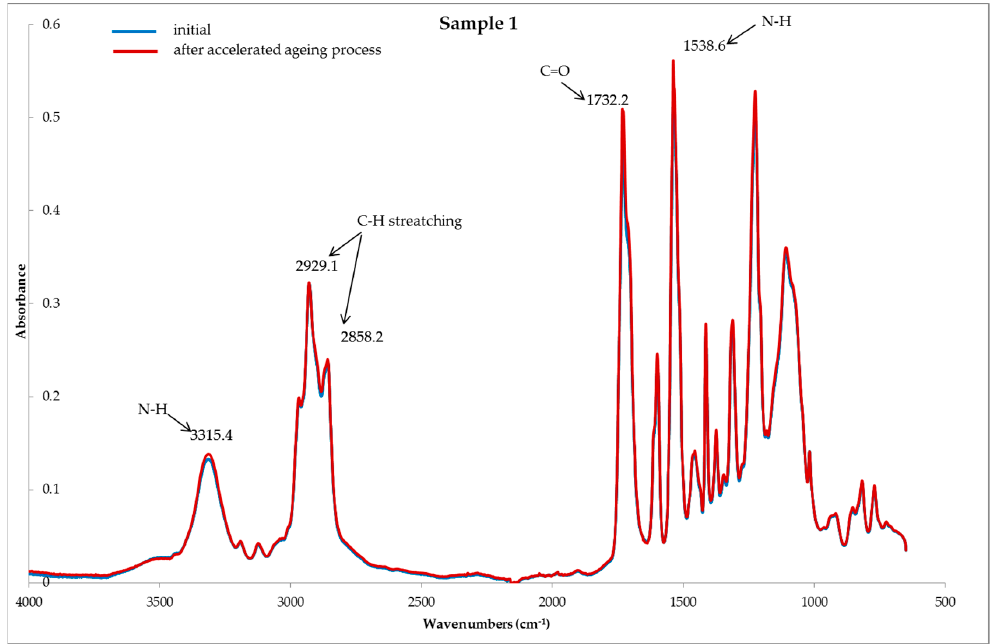
Figure 2. FTIR spectra of sample 1; samples, — initial (before) and — after the accelerated aging process.